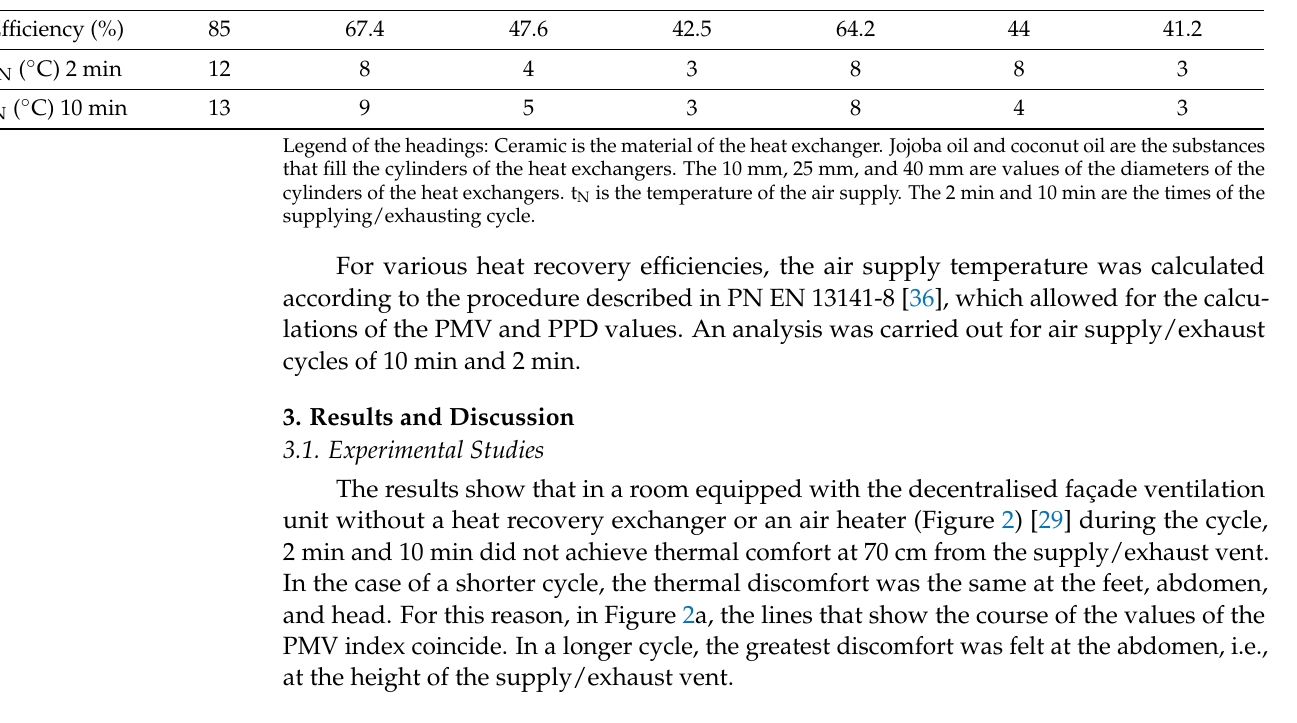
Table 4. Efficiency of heat recovery and temperature of the supply air.